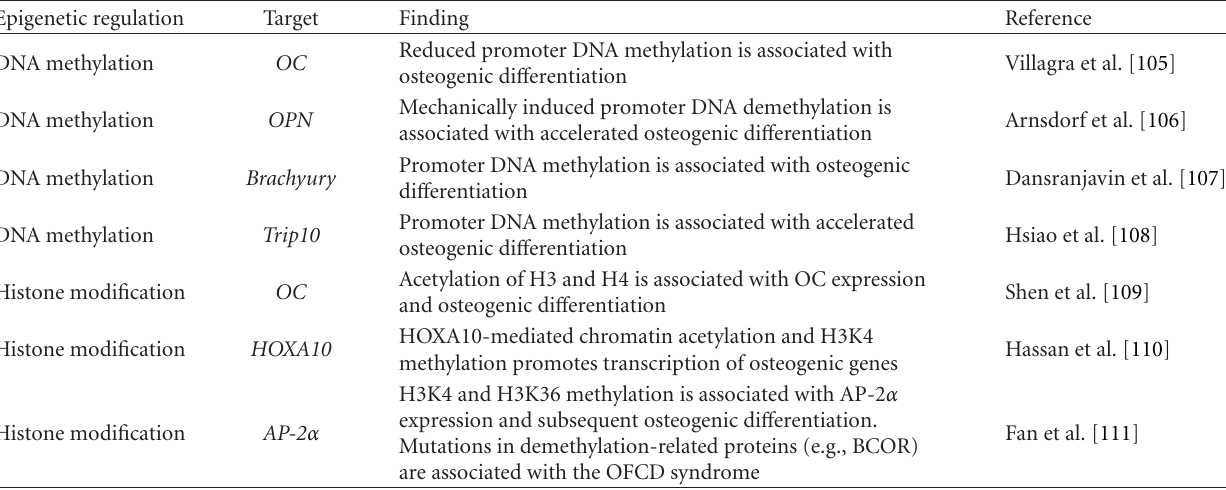
Table 2: Epigenetic regulation of osteogenic di ff erentiation of mesenchymal stem